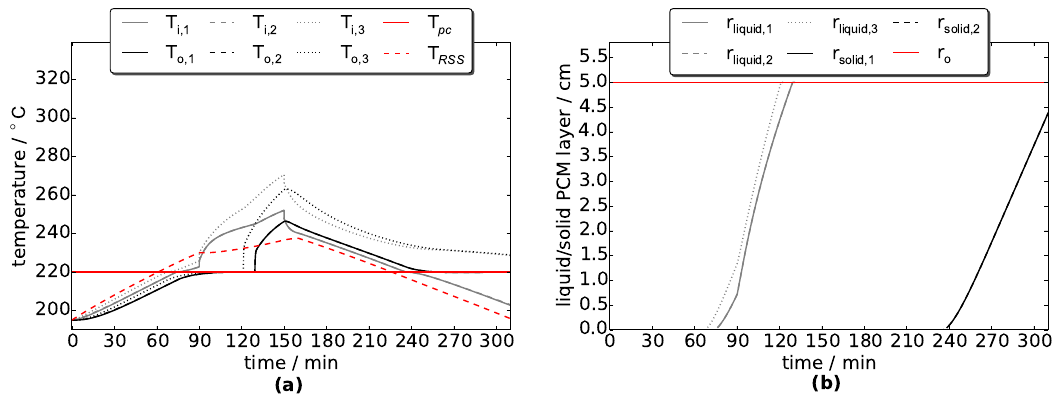
Figure 14. Hybrid storage example results. ( a ) Phase change temperature ( T pc ), inner ( T i , j ) and outer ( T o , j ) temperature of each PCM chamber ( i ). ( b ) Liquid ( r liquid , j ) and solid ( r solid , j ) layer thickness during phase change of each phase change material (PCM) chamber ( j